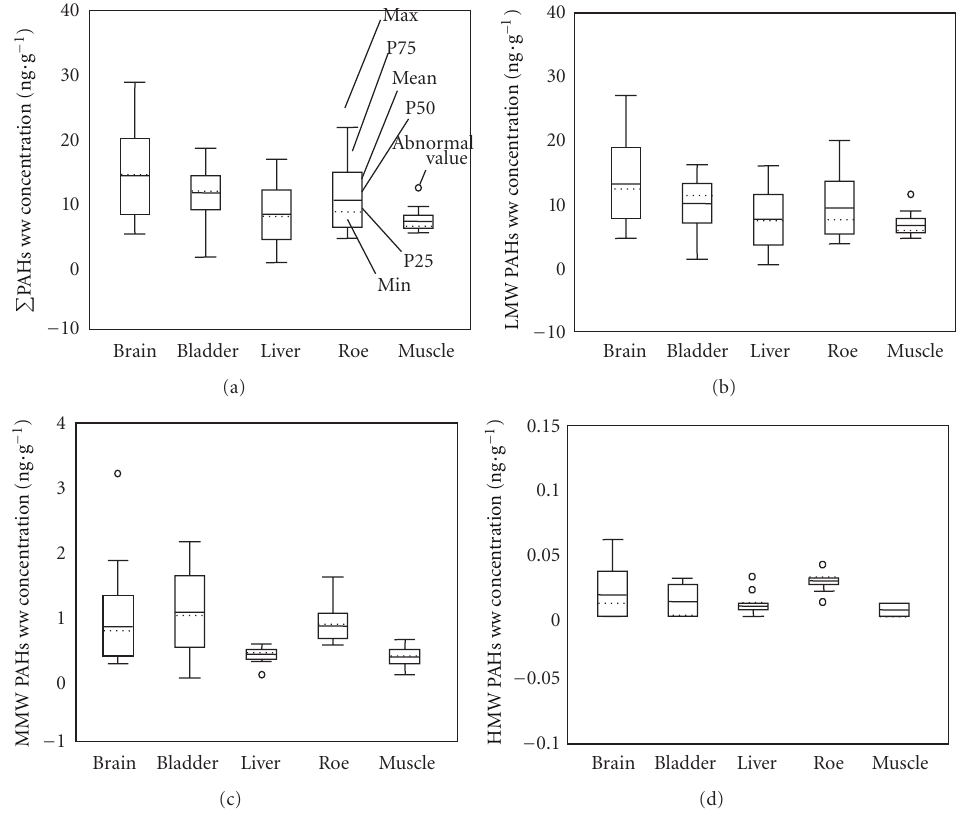
Figure 4: Wet weight contents of (a) total PAHs (PAH16), (b) LMW-PAHs, (c) MMW-PAHs, and (d) HMW-PAHs in four fish tissues. Table 6: ANOVA results of lipid normalized-based tents. PAHs Mean square F value Sig.